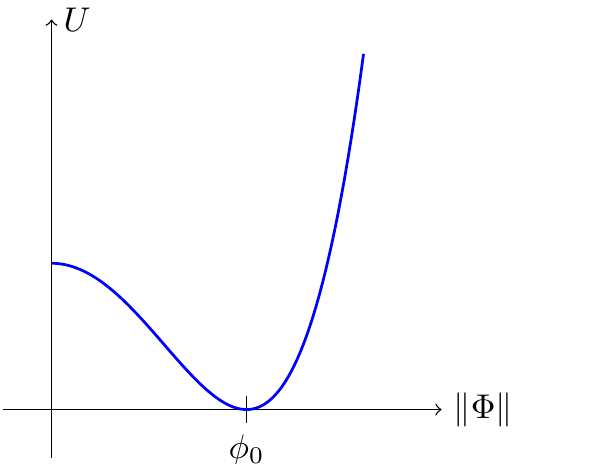
(cid:8) = (cid:30) 0 . We choose k k